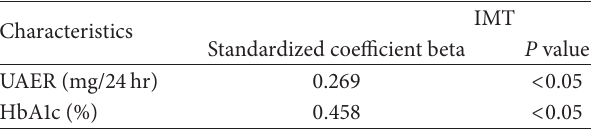
Table 3: Multiple stepwise regression